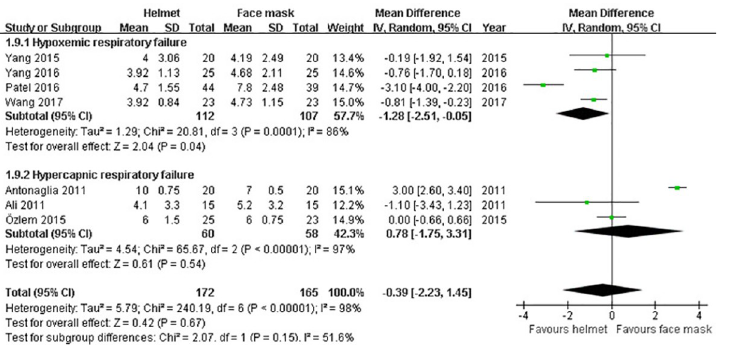
Fig 11. Forest plot of ICU stay.